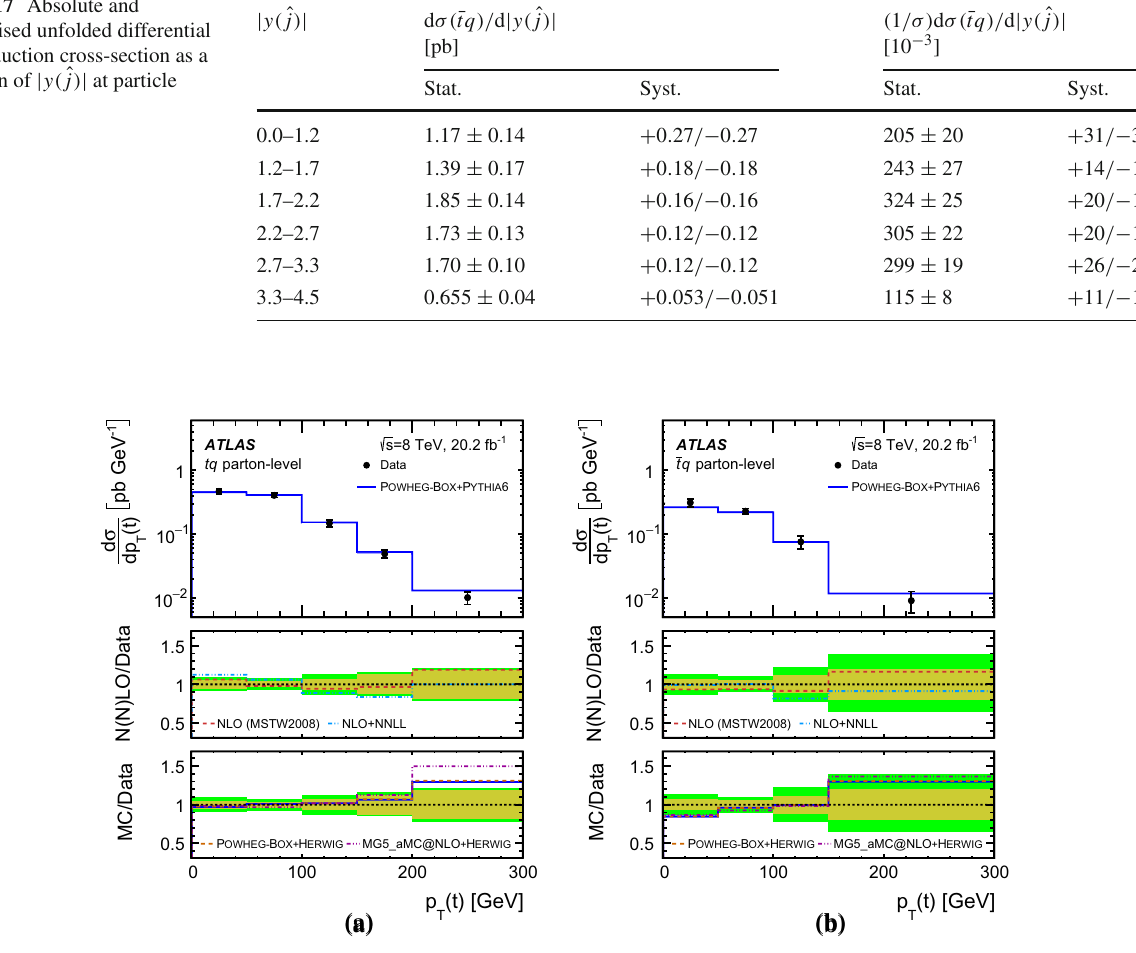
Fig. 21 Absolute unfolded differential cross-sections as a function of p T ( t ) for a top quarks and b top antiquarks. The unfolded distributions are compared to QCD NLO and NLO + NNLL calculations as well as various MC predictions. The vertical error bars on the data points denotethetotaluncertainty.The dashed ( red ) line inthecentraldistribu- tion shows the NLO prediction calculated using MCFM. The dash-dot